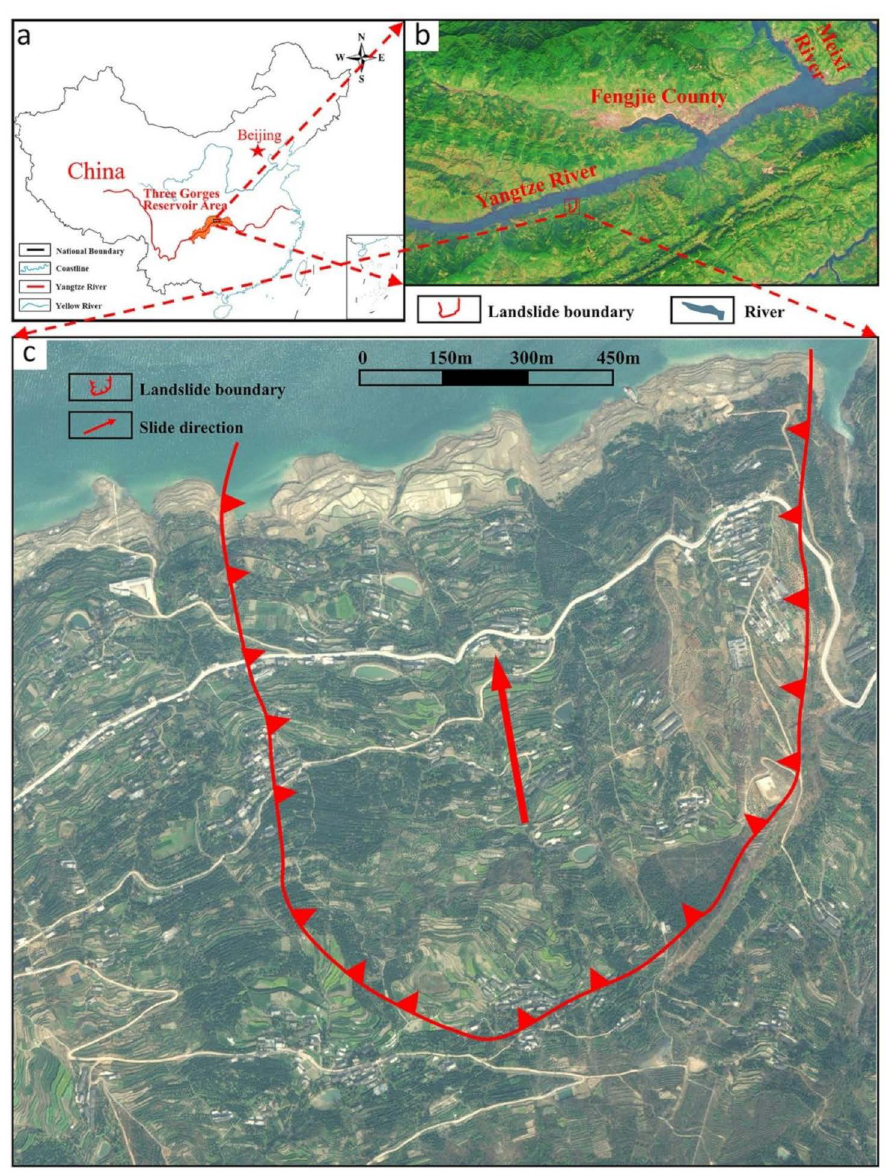
Figure 4. ( a ) Location of the Three Gorges Reservoir Area (TGRA) in China; ( b ) location of the Shengjibao landslide; ( c ) overall view of the Shengjibao landslide (satellite image from Google